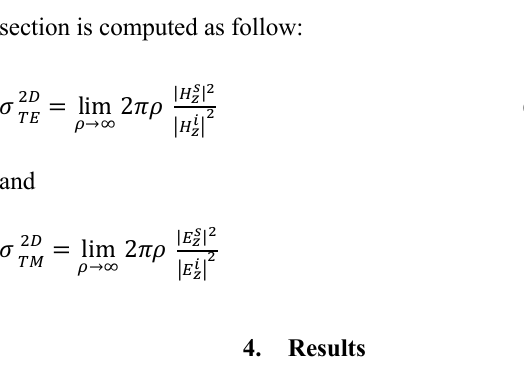
Fig.3. The distribution of the electric fields 𝐸 filled IRTG at y=0 ( 𝜀 = 2.5 − 𝑗0.2 , 𝜇 Q# ) with 𝑊 = 4𝜆 . (a) TE mode, (b) TM 𝜀 = 𝜀 , 𝜇 = 𝜇 F A F A